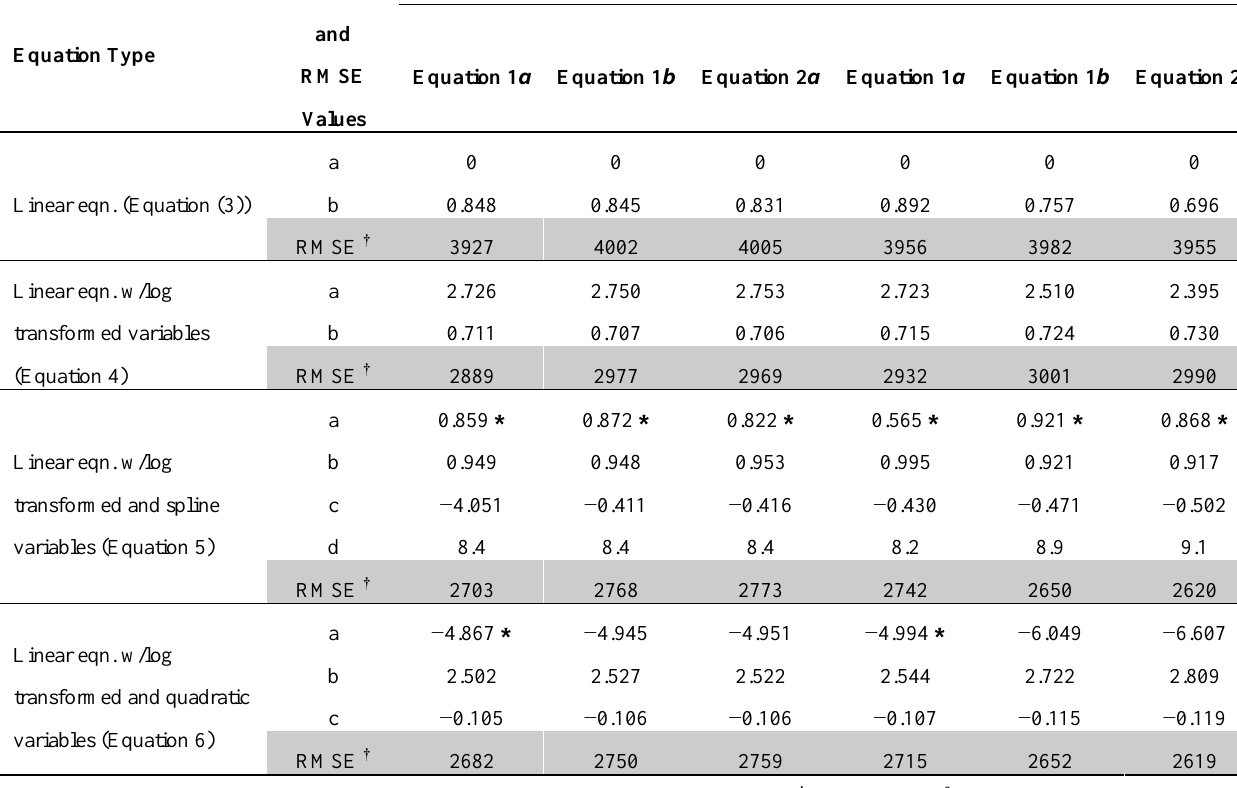
Table 2. Summary of gravimetric equivalency conversion for the three humidity adjusted results (with and without a 60% RH threshold) utilizing a linear, linear with log transformed variables, linear with log transformed and spline variable, and linear with log transformed and quadratic variable